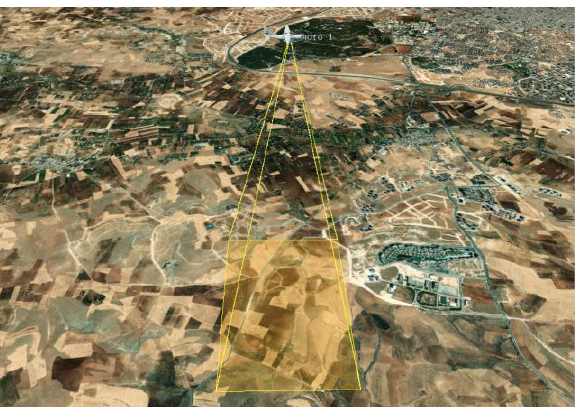
Figure 2 . Geovisualization of the footprint of an aerial